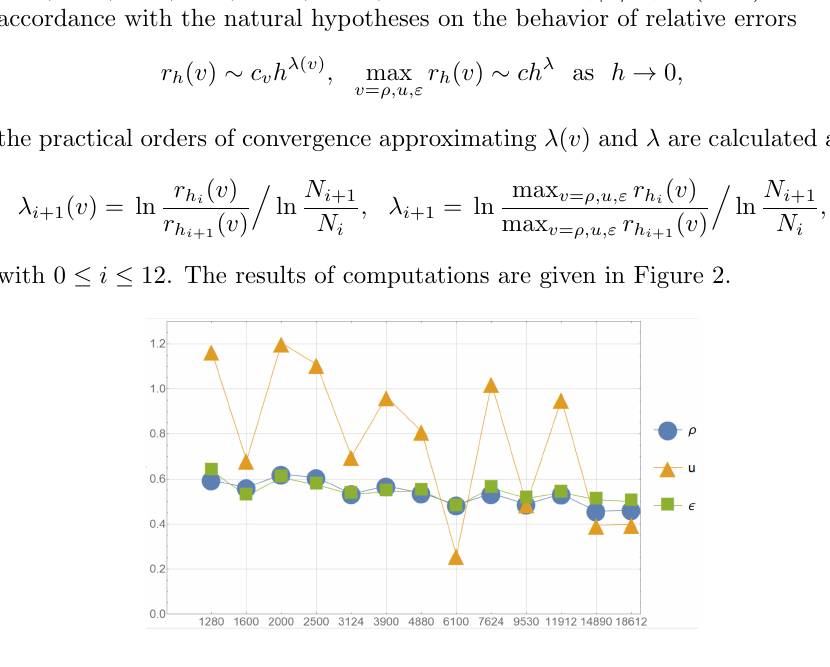
Figure 2. Test 1. The practical orders of convergence λ i +1 ( v ), v = ρ,u,ε , in dependence on N i +1 , 0 ≤ i ≤ 12 It should be noticed that λ i ( ρ ) and λ i ( ε ) fluctuate moderately within respec- tively [0 . 456 , 0 . 621] and [0 . 478 , 0 . 637] and differ little from each other,